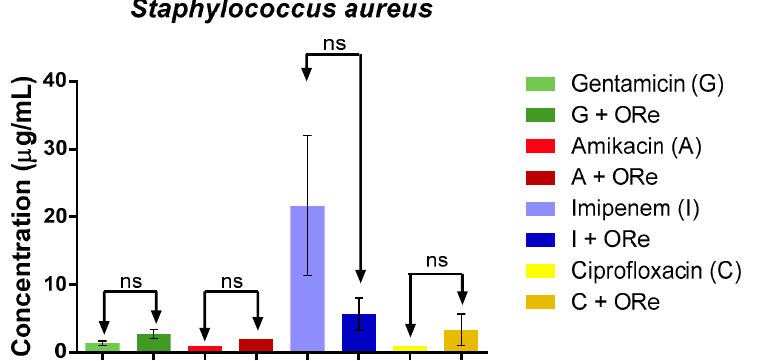
Figure 6. Minimum inhibitory concentration of antibiotics in the presence and absence of R. echinus leaf essential oil for Staphylococcus aureus . Statistical analysis: one-way ANOVA followed by Bonferroni post-hoc test, ns, not significant. ORe = R. echinus leaf essential oil. Ns, indicates significant difference when R. echinus leaf essential oil was added to the medium. G = gentamicin, A = amikacin, I = imipenem, C = ciprofloxacin. Data show mean + SEM from three independent experiments performed in triplicate.